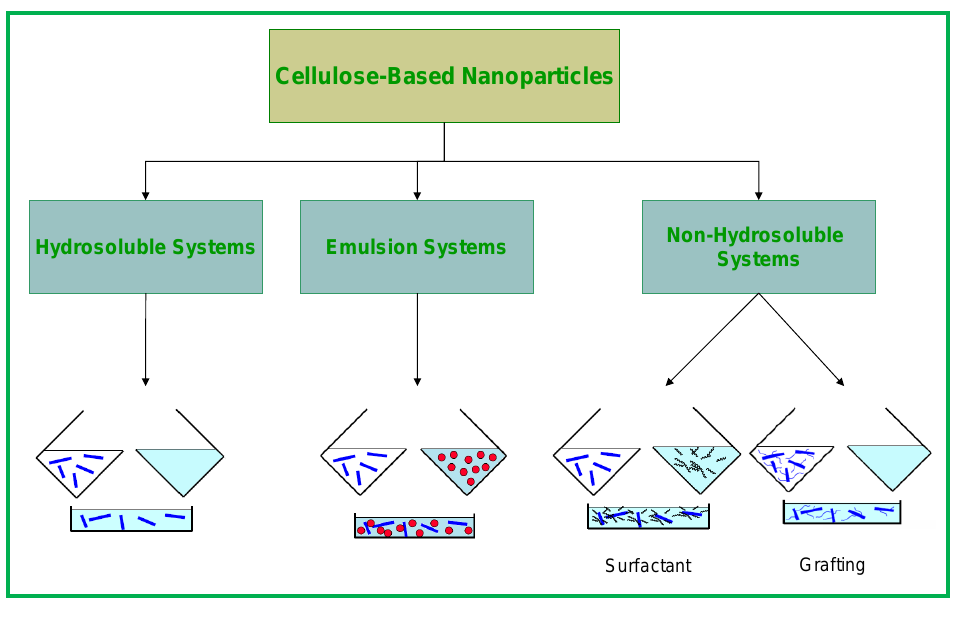
Figure 5. General scheme of strategies used for preparation of cellulose based nanocomposites by solvent